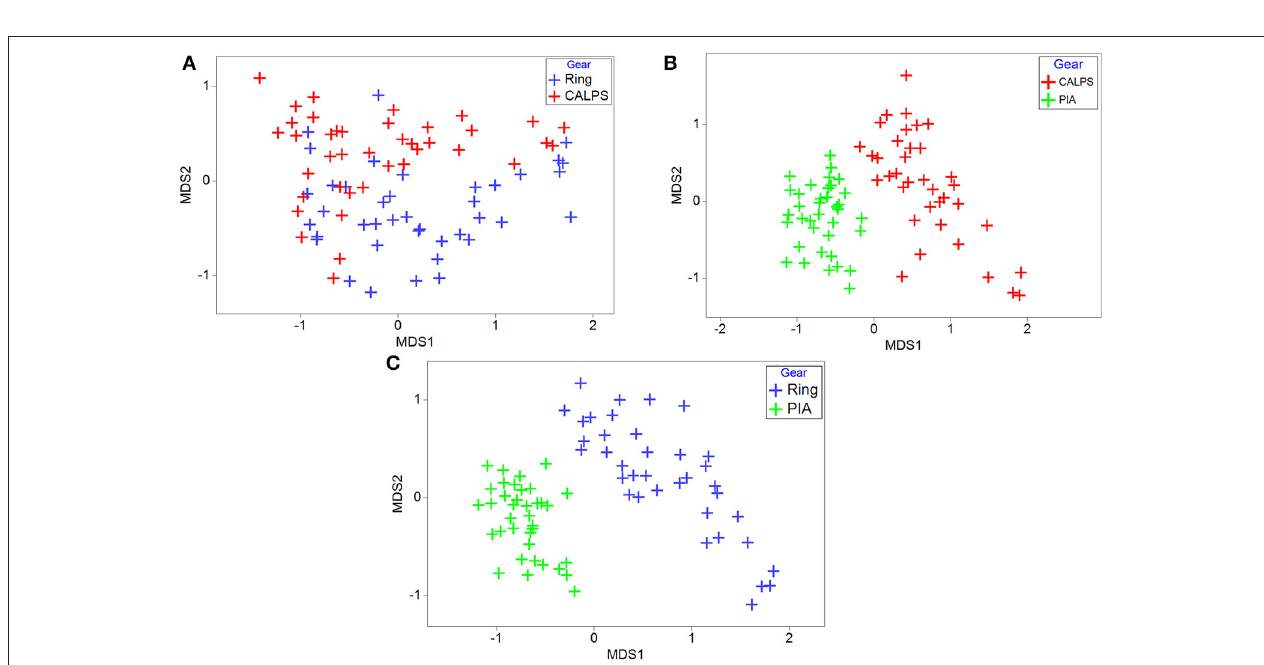
FIGURE 6 | Differences in zooplankton community structure between ring Net, CALPS, and PIA datasets. Relative abundances contributed by individual taxa to total abundance from samples taken with the ring net, CALPS and PIA. Non-metric MDS scatter plot of all samples collected with two gears based on the rank order of sample similarities. (A) CALPS vs. ring net, (B) PIA vs. CALPS, (C) PIA vs. ring